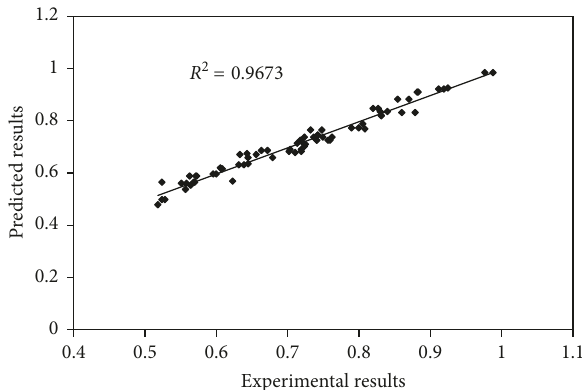
Figure 15: Linear relationship between measured and predicted flexural strengths for the Polak–Ribiere conjugate gradient back- propagation algorithm of ANN.